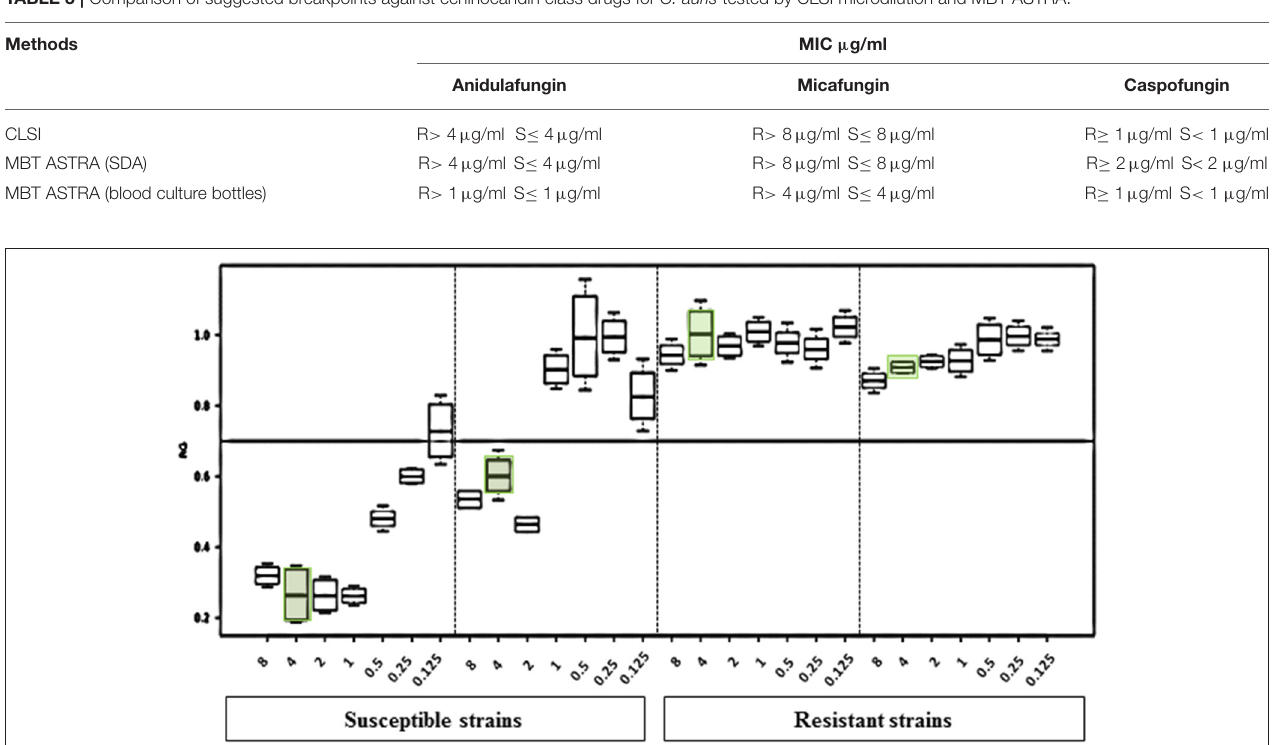
FIGURE 1 | Results of the MBT ASTRA prototype software evaluation. The relative growth values of 2-fold serial dilutions of anidulafungin of 2 susceptible and 2 resistant C. auris strains after 6h incubation show distinct differences. The susceptibility/resistance threshold was set at a RG value of 0.7. For susceptible strains, at the concentration of 4 µ g/ml anidulafungin a significant reduction of the relative growth was